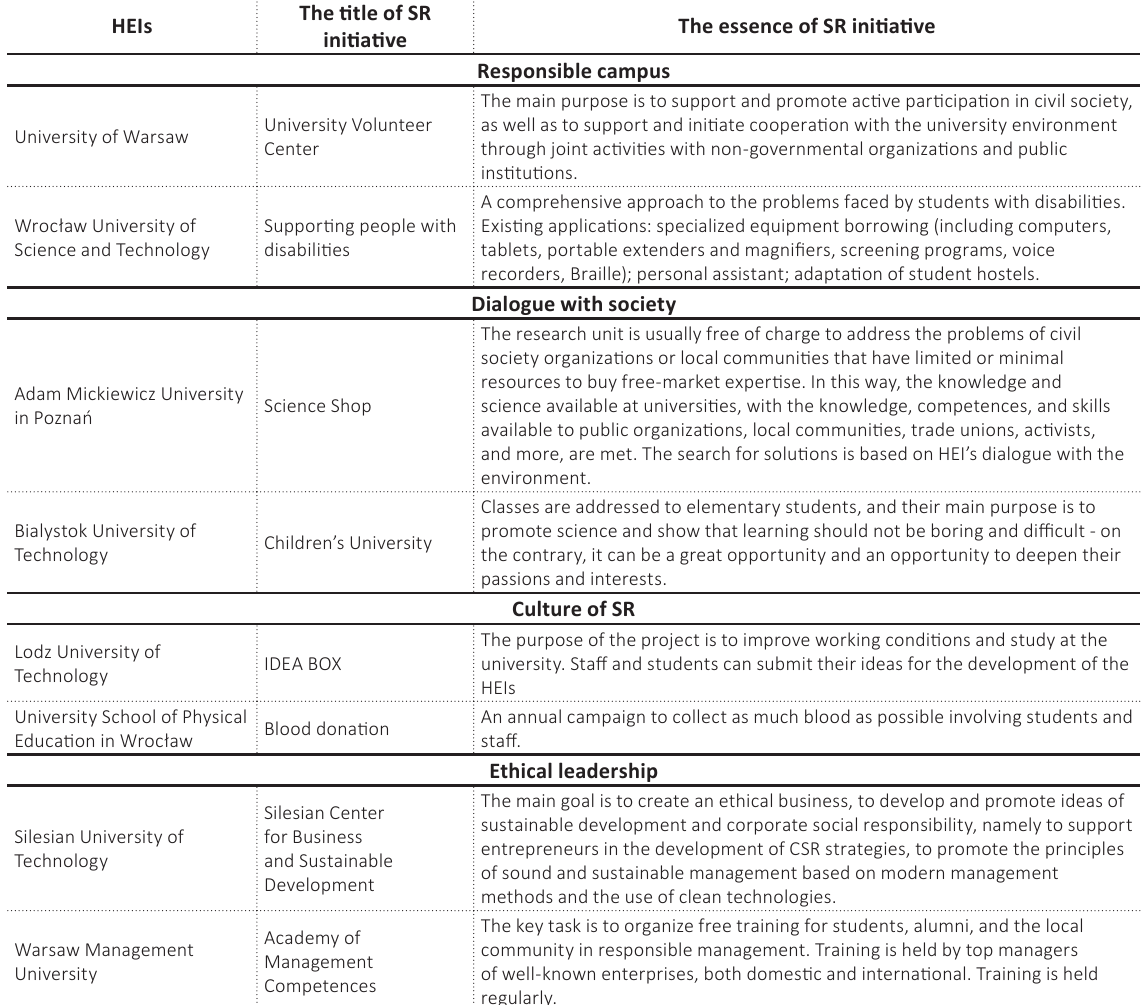
Table 9 (cont.). SR examples of Polish